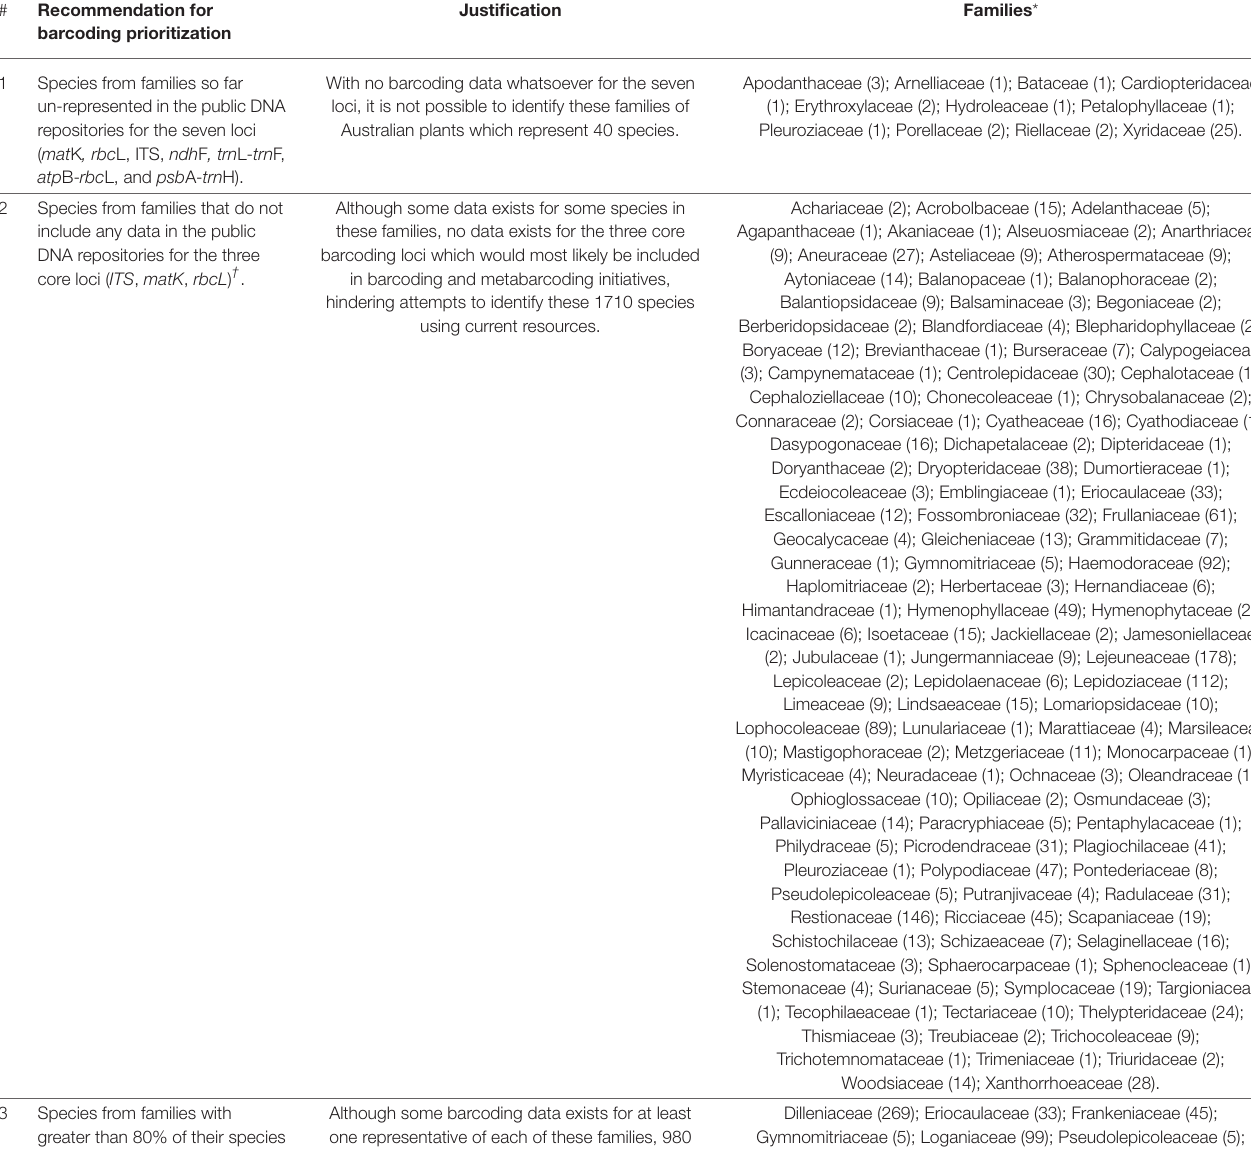
TABLE 1 | Recommendations for priority taxa for barcode database building in Australia, based on a survey of data available in GenBank against the Australian Plant Census.